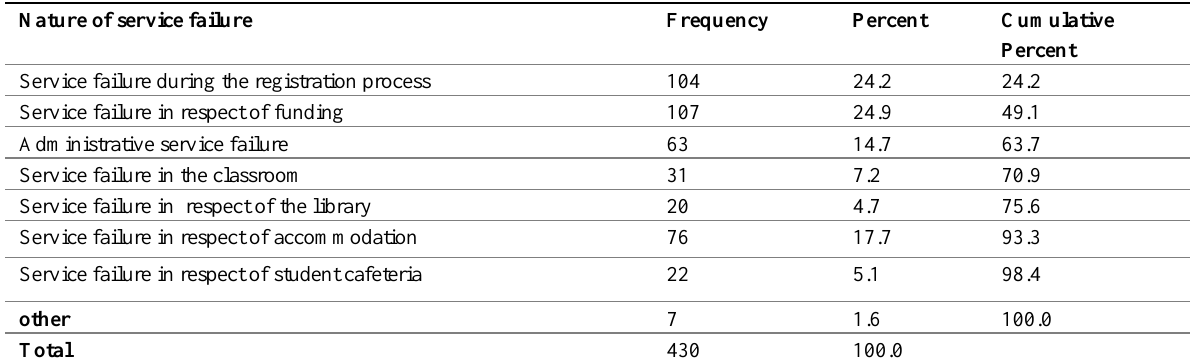
Table 2: Nature of the service failure for the services provided at